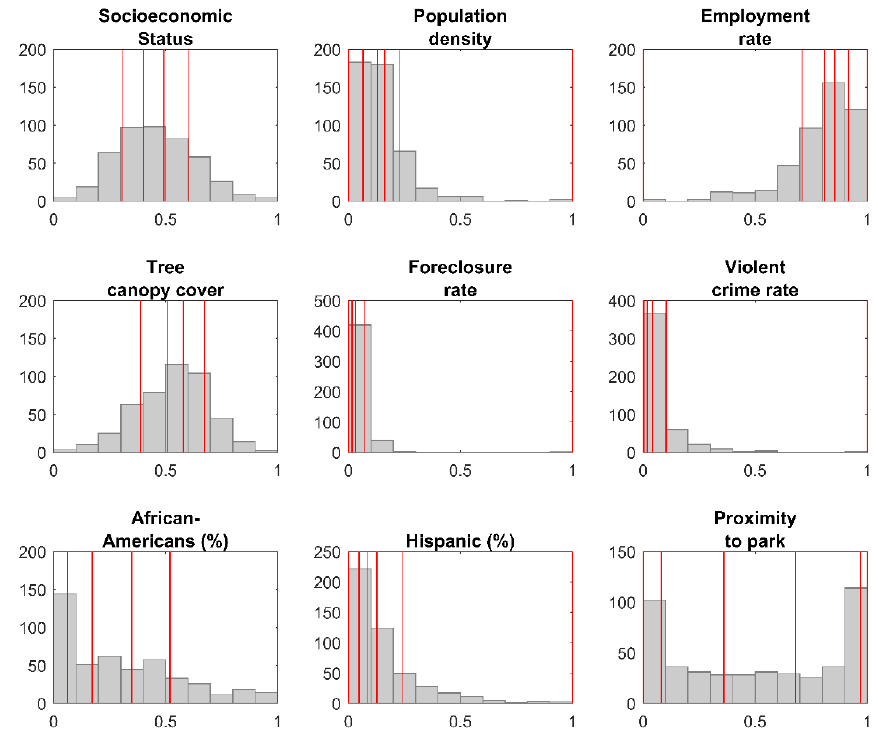
Figure 3. Histogram for each of nine variables used in the optimization process, using all NPAs. The red lines indicate the limits of each quintile.